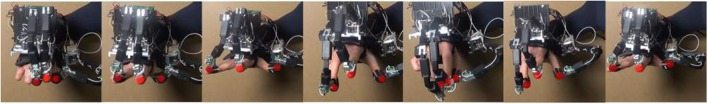
Snapshots corresponding from left to right to the a, b, c, d, e, f, and g points in Figure 6.